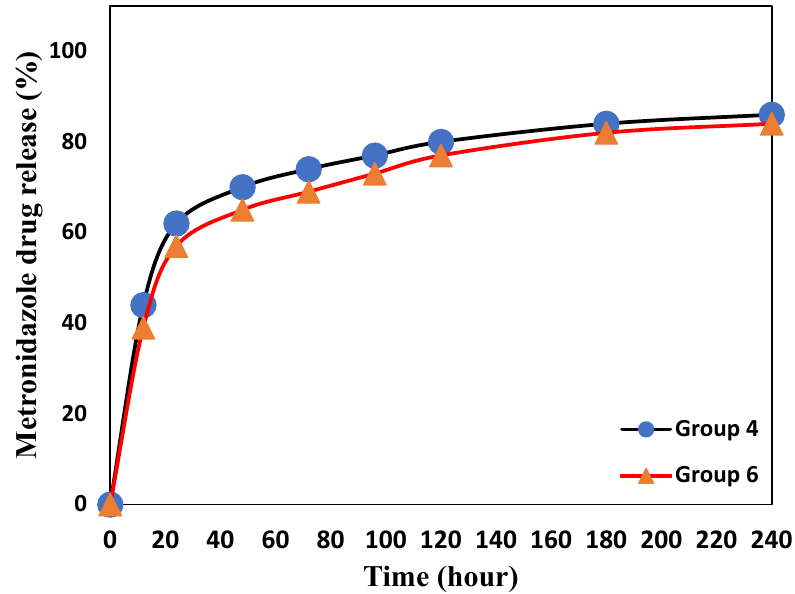
Figure 6. In vitro metronidazole release profile from GIC Group 4—1.5% metronidazole + 0.5% TVE-CuNPs + 98% GIC. Group 6—1.5% metronidazole + 0.5% AgNPs + 98% GIC.